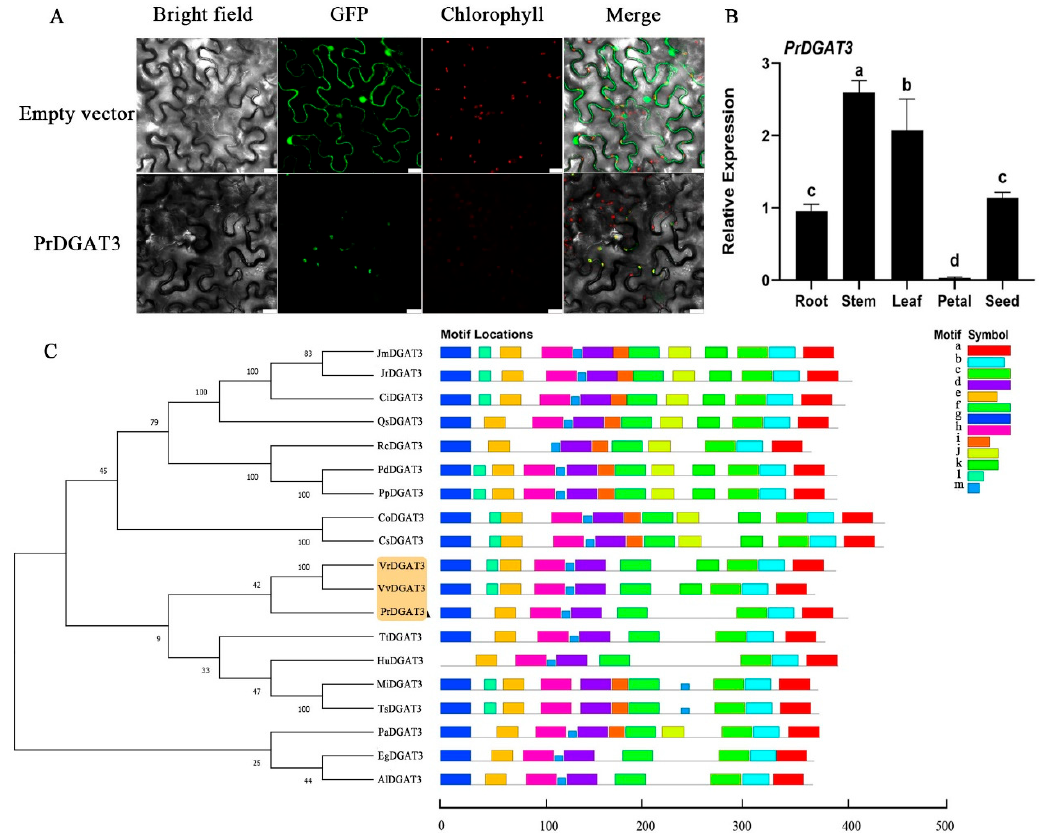
Figure 1. Expression profile and molecular characterization of PrDGAT3. ( A ) Subcellular localization of the PrDGAT3 protein fused with GFP (pCAMBIA2300- PrDGAT3-GFP ) in tobacco leaf cells. Bars = 20 µm. ( B ) PrDGAT3 expression in various tissues of P. rockii. Values are mean ± SD ( n = 3) . ( C ) Phylogenetic tree and conserved motifs of the PrDGAT3. Different letters indicate significant difference at p < 0.05, as confirmed by one-way ANOVA with Tukey’s post hoc test.